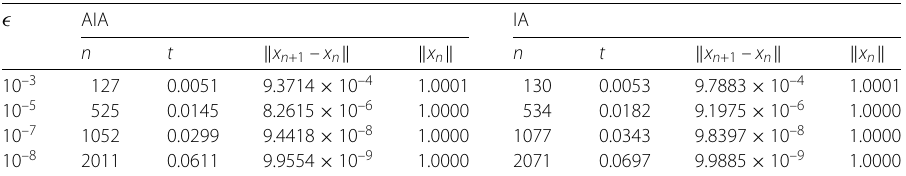
Table 3 Comparison of Algorithm 3 (AIA) with Algorithm 1 (IA) for Example 4.2. u = sin t , x 0 = t